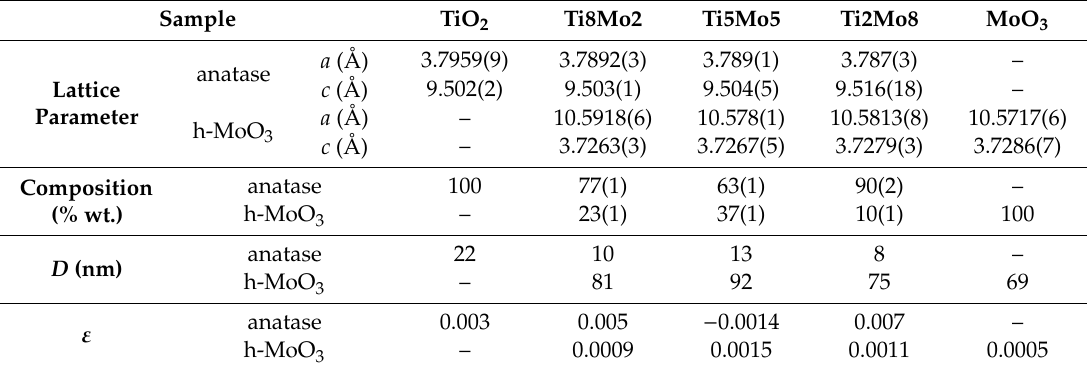
Table 2. Lattice parameters, phase composition, crystallite sizes ( D ) and lattice strain ( ε ) for synthesized materials based on TiO 2 and MoO 3 .